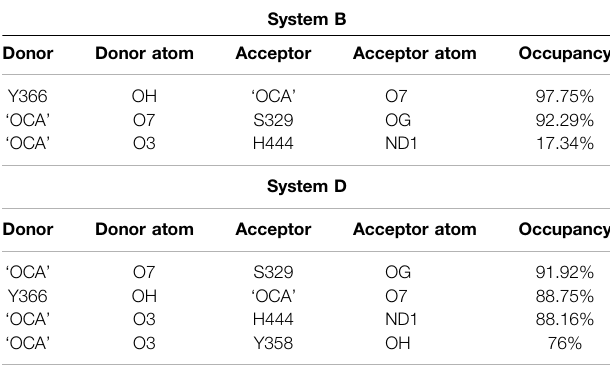
TABLE 2| HBOccupancy(cut-off > 50%)oftheinteractingresidues with ‘ OCA ’ in both systems B and